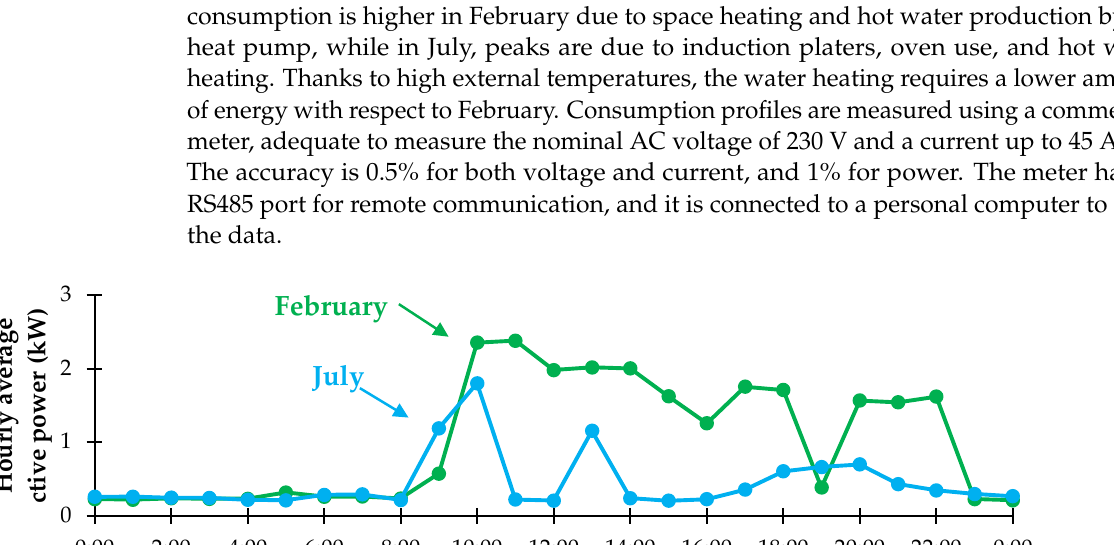
Figure 6. Monthly electricity consumption of the analyzed residential user.